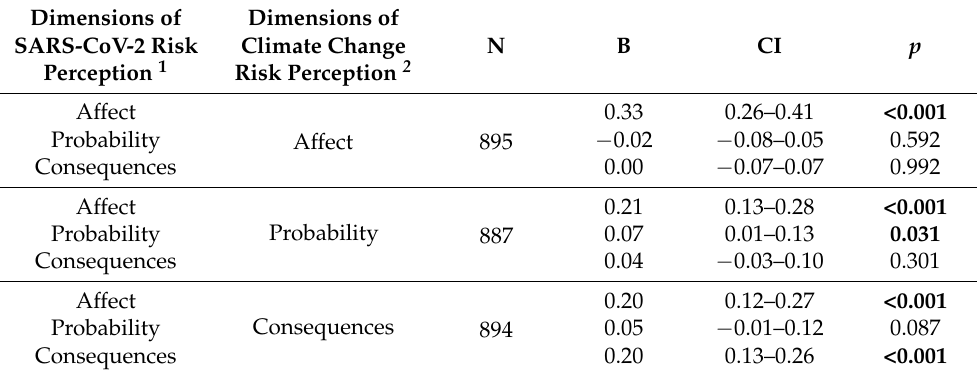
Table 5. Results of the three adjusted linear regression models regarding the association of all dimensions of risk